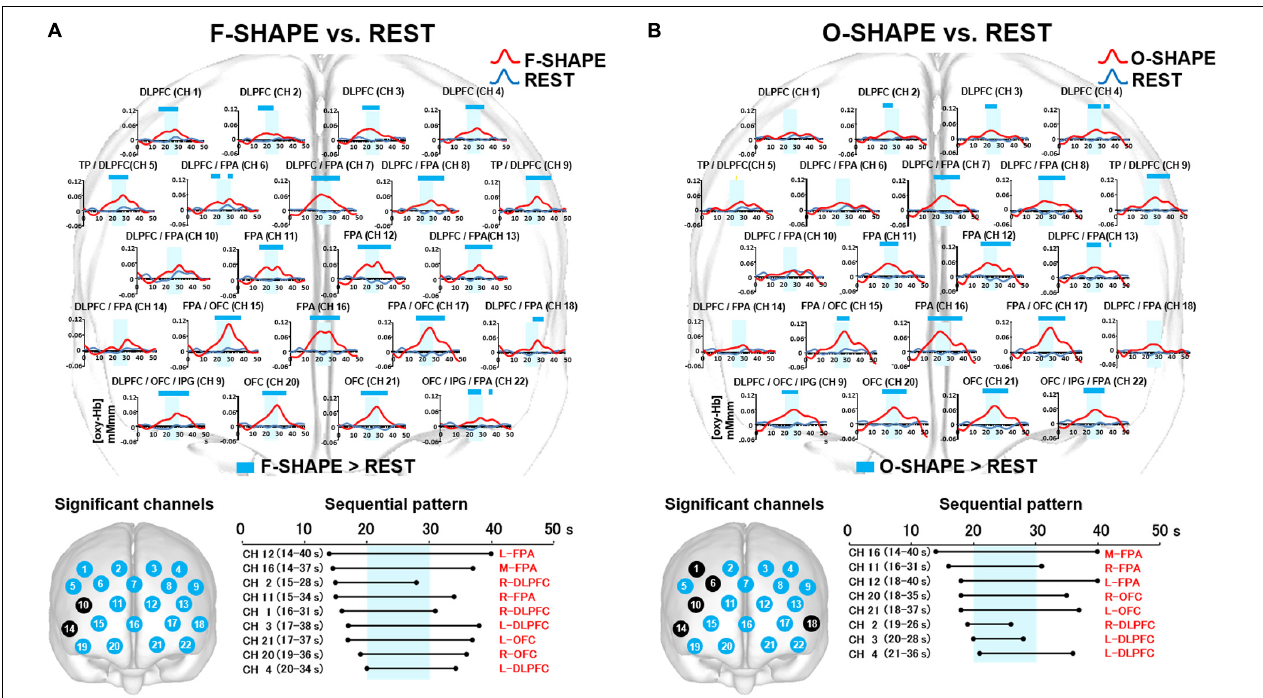
FIGURE 3 | Prefrontal functional near-infrared spectroscopy (fNIRS) activities in SHAPE as compared to REST. (A) Temporal differences and sequential pattern of the prefrontal fNIRS activities in F-SHAPE as compared to REST. Most channels presented significant (two-way repeated measures ANOVA and Bonferroni t -test: p < 0.05) prefrontal activation in F-SHAPE as compared to REST. A sequential pattern of significant (two-way repeated measures ANOVA and Bonferroni t -test: p < 0.05) prefrontal activations also presented temporally overlapped features in the onset and duration of the dorsolateral prefrontal cortex (DLPFC)/frontopolar area (FPA)/orbitofrontal cortex (OFC) activities preceding, during, and following the task periods in F-SHAPE as compared to REST. (B) Temporal differences and sequential pattern of the prefrontal fNIRS activities in O-SHAPE as compared to REST. Most channels presented significant (two-way repeated measures ANOVA and Bonferroni t -test: p < 0.05) prefrontal activation in O-SHAPE as compared to REST. A sequential pattern of significant (two-way repeated measures ANOVA and Bonferroni t -test: p < 0.05) prefrontal activations also presented temporally overlapped onset and duration of the DLPFC/FPA/OFC activities preceding, during, and following the task periods in O-SHAPE as compared to